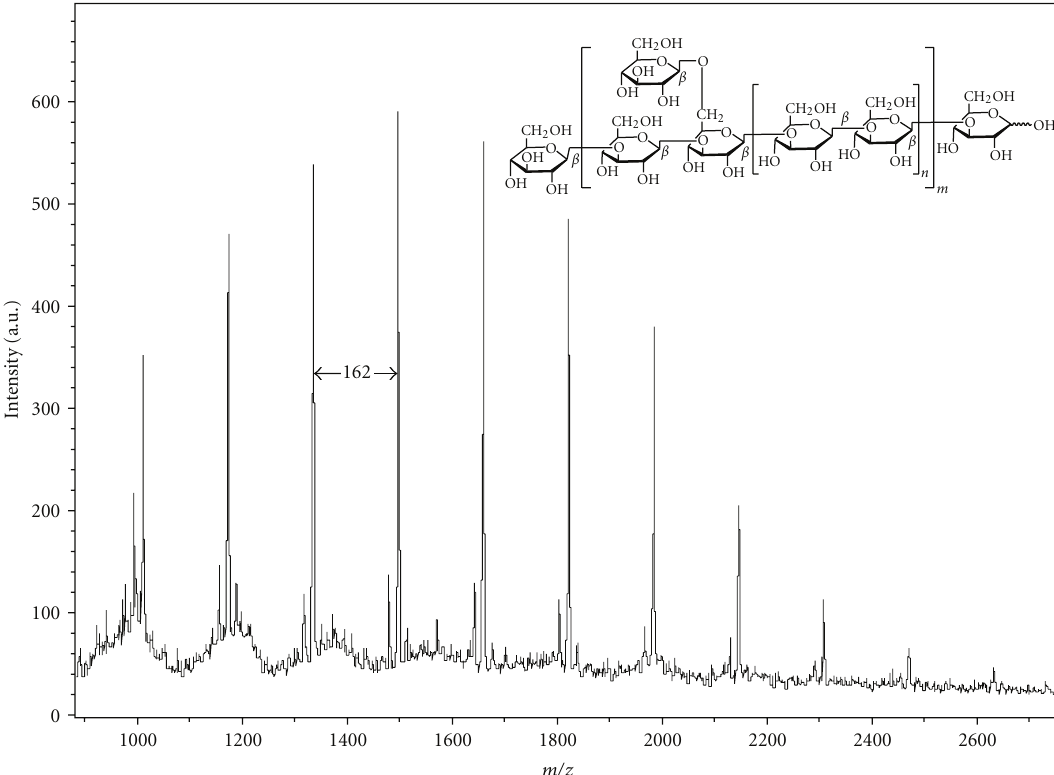
Figure 4: MALDI-TOF with 2,5-DHB as matrix, determined the molecular mass of LMG. The gap with 162 Da between peaks represents a hexose unit in LMG. Sodiated ions ([Glcn + Na] + ) appeared at DP = 6 to 15 with 1013.1, 1175.1, 1337.1, 1499.1, 1661.2, 1823.2, 1985.2, 2147.2, 2309.2, and 2471.3 Da, respectively.